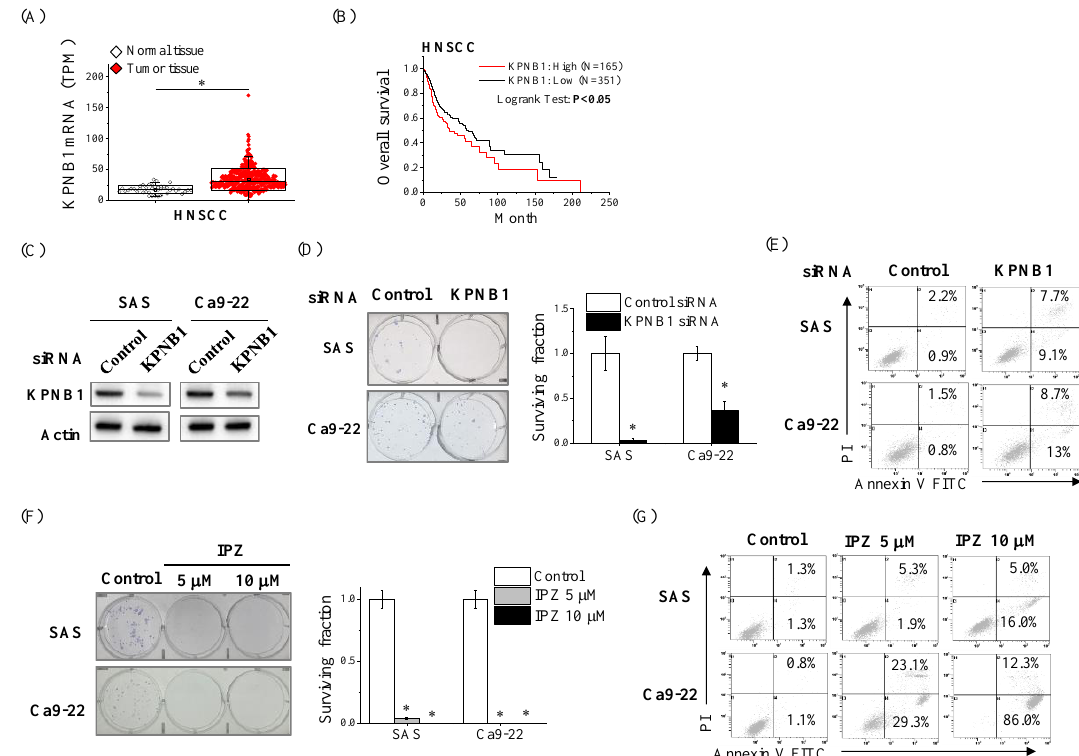
Figure 1. High expression levels of karyopherin- β 1 (KPNB1) determines the proliferation, as well as the apoptosis resistance, of head and neck squamous cell carcinoma (HNSCC) cells. ( A ) The expression of KPNB1 in non-tumor tissue and HNSCC samples from Cancer RNA-Seq Nexus are shown. * indicates p < 0.01. ( B ) The relationship between the overall survival and KPNB1 expression of HNSCC patients in the The Cancer Genome Atlas (TCGA) cohorts is shown. The patients whose KPNB1 mRNA expression z-Scores (RNA Seq V2 RSEM) is greater than 0.5 SD above mean were defined as KPNB1 high patients. ( C ) HNSCC cells (SAS and Ca9-22 cells) transfected with control or KPNB1 siRNA were harvested, and KPNB1 protein expressions were analyzed by Western blot. The representative image of immunoblot is shown. Actin was used as loading control. ( D ) The clonogenic potential of HNSCC cells transfected with control or KPNB1 siRNA was estimated by colony formation assay. (Left) The representative pictures of the colonies are shown. (Right) The number of colonies from the cells transfected with control siRNA is considered 1.0. Data are presented as the mean ± SD of at least three independent experiments. * p < 0.05 versus control siRNA. ( E ) HNSCC cells transfected with control or KPNB1 siRNA were cultured for 4 days, and harvested for apoptosis assay using annexin V / propidium iodide (PI) staining. The representative cytograms of annexin V / PI are shown. The inset numbers indicate the proportion of annexin V + / PI − cells or annexin V + / PI + cells. ( F ) (Left) The representative pictures of the colony of HNSCC cells cultured in the presence of dimethyl sulfoxide (DMSO) or importazole (IPZ) are shown. (Right) The number of colonies from the cells treated with DMSO control is considered 1.0. Data are presented as the mean ± SD of at least